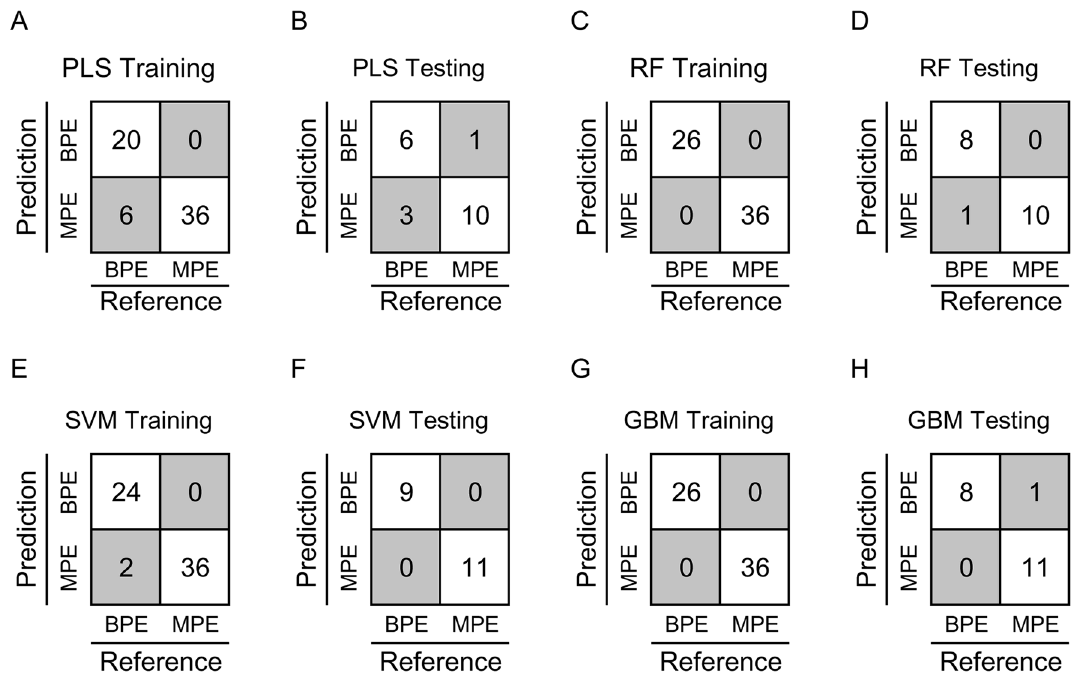
Figure 3. Predictive performance of the 4 models in train set and test set. PLS modeling in train set ( A ) and test set ( B ); RF modeling in train set ( C ) and test set ( D ); SVM modeling in train set ( E ) and test set ( F ); GBM modeling in train set ( G ) and test set ( H ). Good prediction is defined when predictive class is the same as the reference (no background), otherwise bad prediction is defined (gray